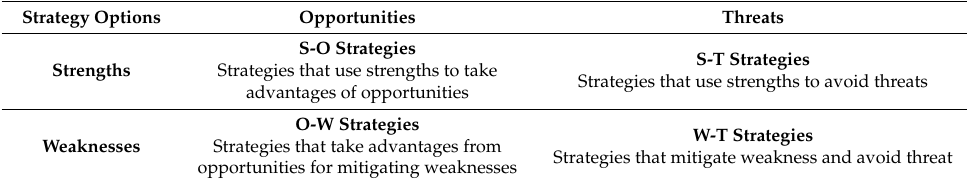
Table 5. TOWS analysis and strategy options.